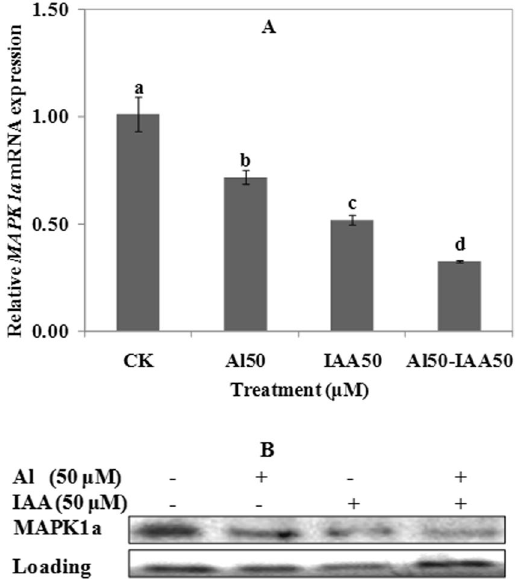
Figure 9. Expression of MAPK1a in wheat, RNA ( A ) and protein ( B ). Real time quantitative RT-PCR and western blot was used to assess MAPK1a gene and protein expression in root apexes (0–20 mm) of wheat lines ET8. Seedlings were exposed to 0.5 mM CaCl 2 solution (pH 4.5) containing other chemicals: 0 μ M AlCl 3 (CK), 50 μ M AlCl 3 , 50 μ M IAA, 50 μ M AlCl 3 and 50 μ M IAA for 24 h. Data are means ± SD (n = 3). Small letter differences in the same figure mean significant difference at P < 0.05.